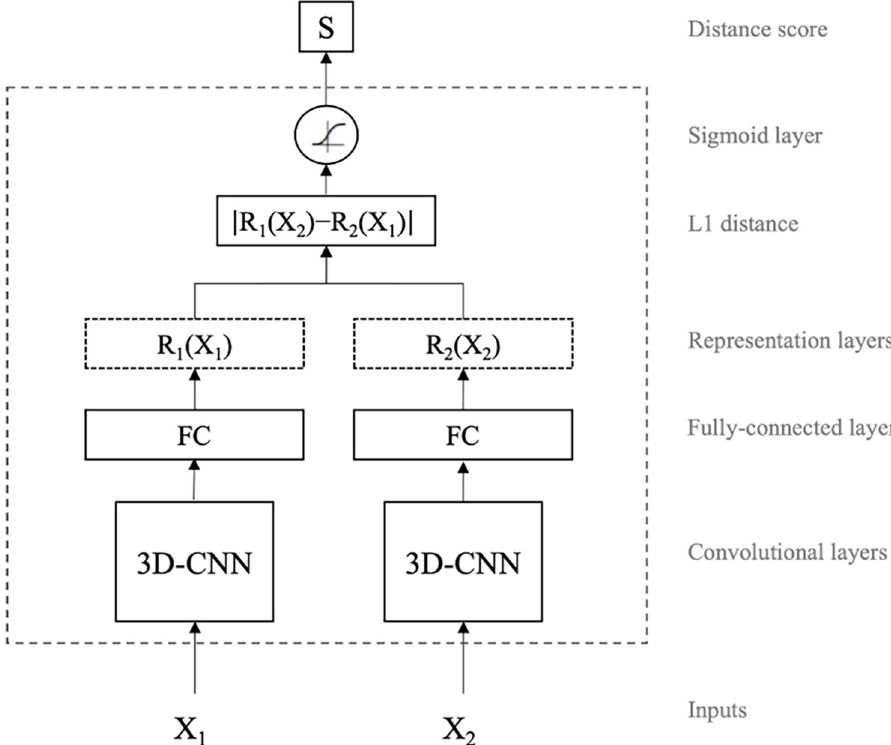
Fig 3. High-level architecture of the proposed model. Siamese networks take two images, X 1 and X 2 , and learn a distance function between the two vector representations of the input images. The model outputs distance score close to one if the two inputs are from two different objects (in this case, different subjects) and close to zero otherwise. The weights of the CNN child networks are updated independently and are not tied/shared.